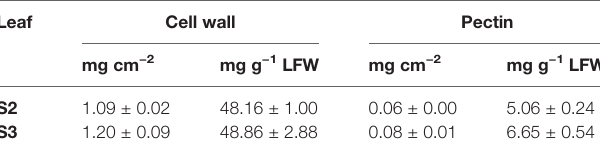
TABLE 2 | Cell wall and pectin content in S2 and S3 leaves.